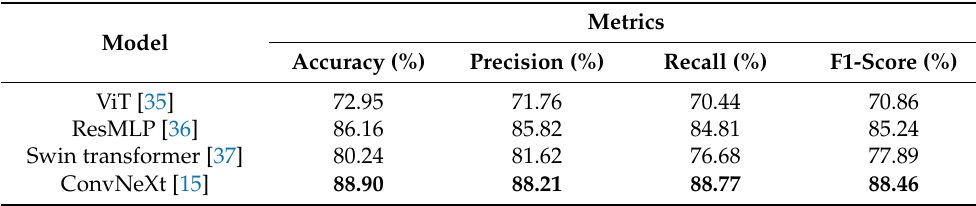
Table 3. Results of SUI BUS CAD systems based on different transformers and ConvNeXt. The best results are highlighted in bold.